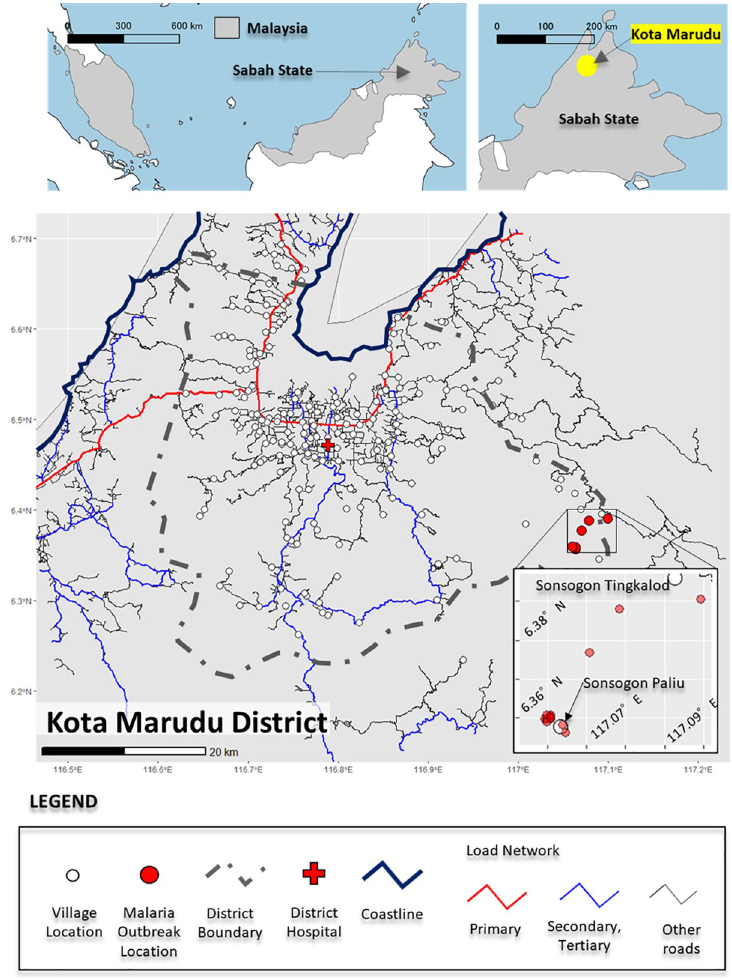
Fig 2. Kota Marudu district. Map of Kota Marudu district showing the location of Sonsogon Paliu village in the south-west of the district. The upper inset shows a map of Malaysia and the location of Kota Marudu district in Sabah state. There are no primary, secondary, tertiary or other road network connections to the village, and the next nearest village is more than 20km away. The lower inset is shows the symptomatic cases represented by red dots. Except for three cases the houses of all the symptomatic cases were very close to each other. Kota Marudu District Hospital is shown as a red-cross. Map was produced using QGIS Version 3.1.6 (QGIS Development Team, 2020). Source of shapefile: https://www.